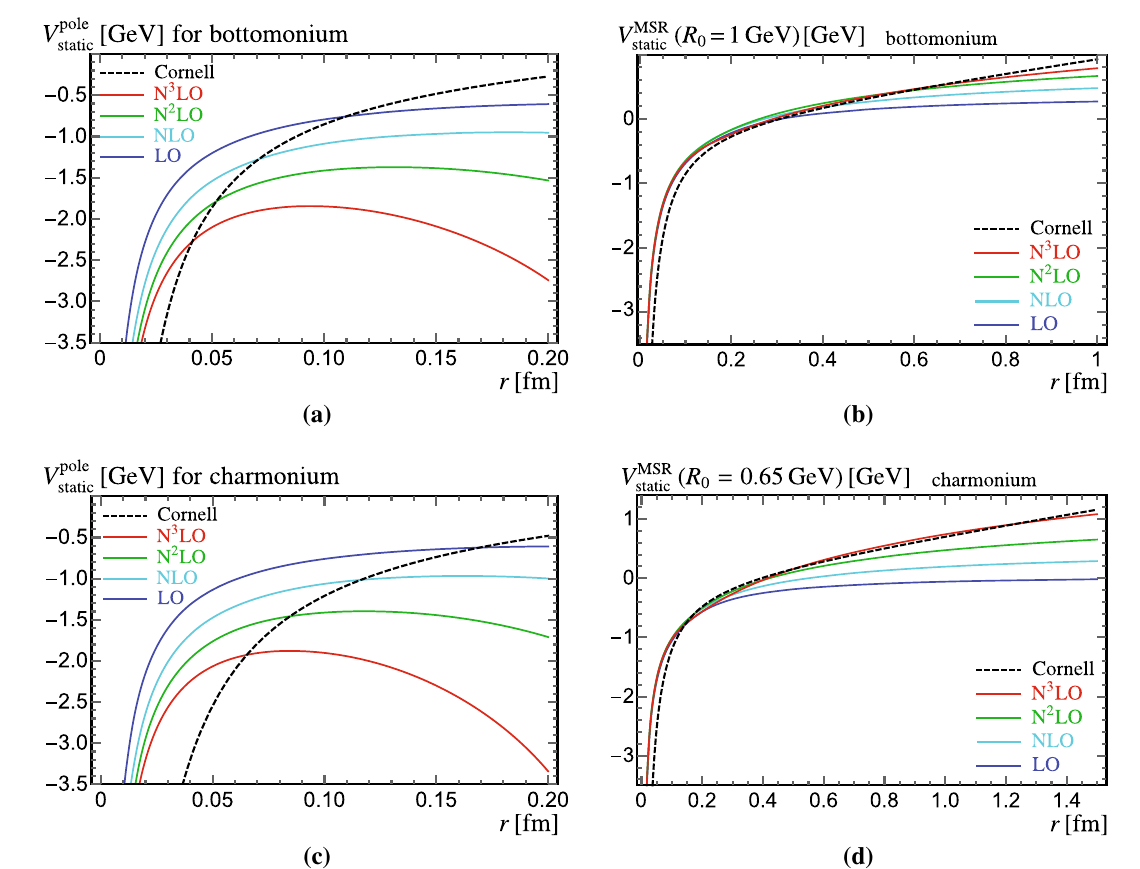
Fig. 7 Comparison of the Cornell potential (dashed black line) with the static QCD potential at N 3 LO (red), N 2 LO (green), NLO (cyan) and LO (blue). Upper (lower) panels correspond to bottomonium (char- monium). The left panels show the static QCD potential in the pole scheme, and the right panels use the MSR scheme with the reference